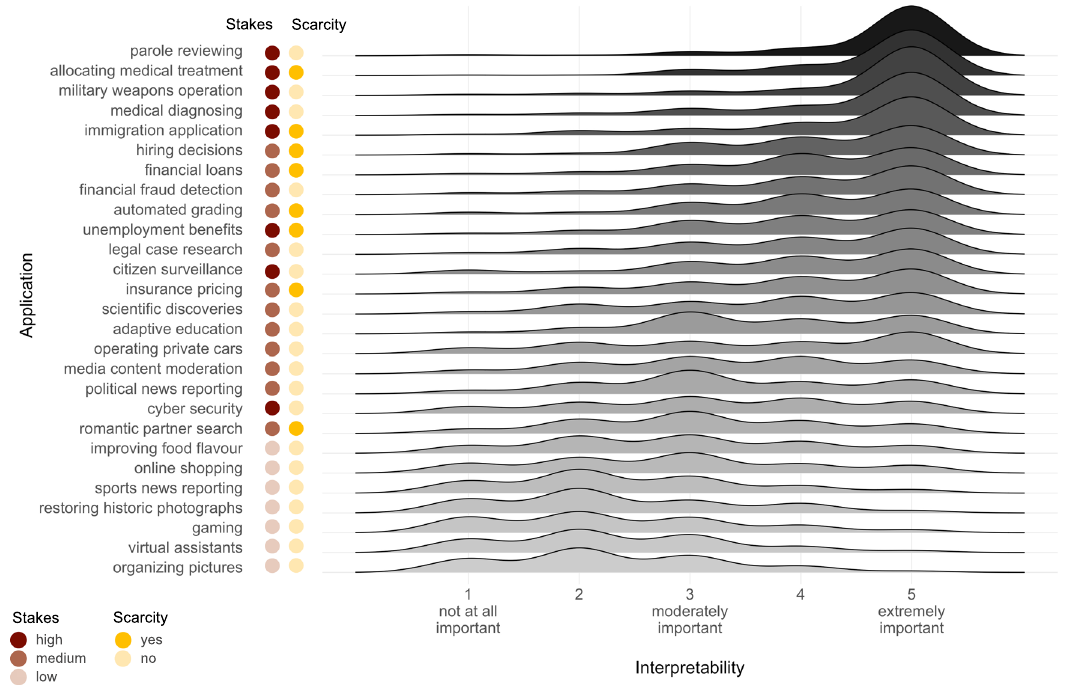
“ howimportantisitthattheAIinthisapplicationisexplainable,evenifitperforms accurately? ” on a 5-point rating scale (1=not at all important, 5=extremely